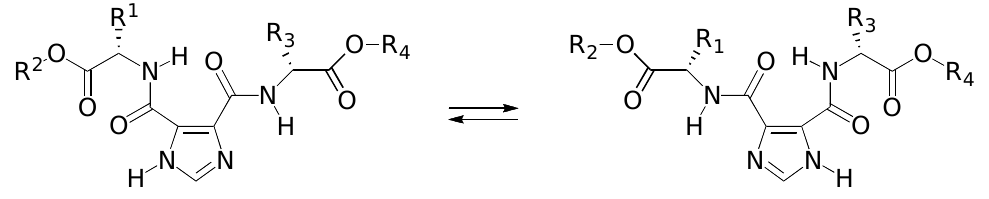
Figure 1. Two intramolecularly hydrogen bonded conformations of the dI45DCs.